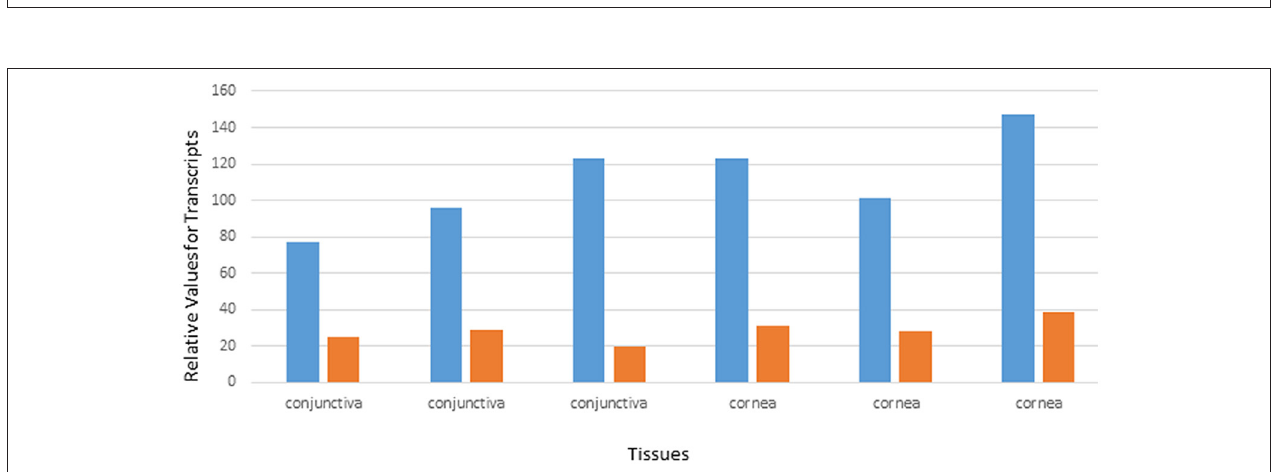
FIGURE 5 | Comparison of cDNA libraries from multiple human tissues for expression of lipocalin-interacting membrane receptor (gray) and tear lipocalin (red). The y-axis shows the percent of the total transcripts. The secondary y -axis, right is scaled differently for tear lipocalin because of the dramatic abundance of this transcript in the lacrimal gland library such that none of the other values appear in the bar graphs. The next most abundant value of percent total transcripts for tear lipocalin was in the testis 0.003%. Data was provided in the Unigene data base.